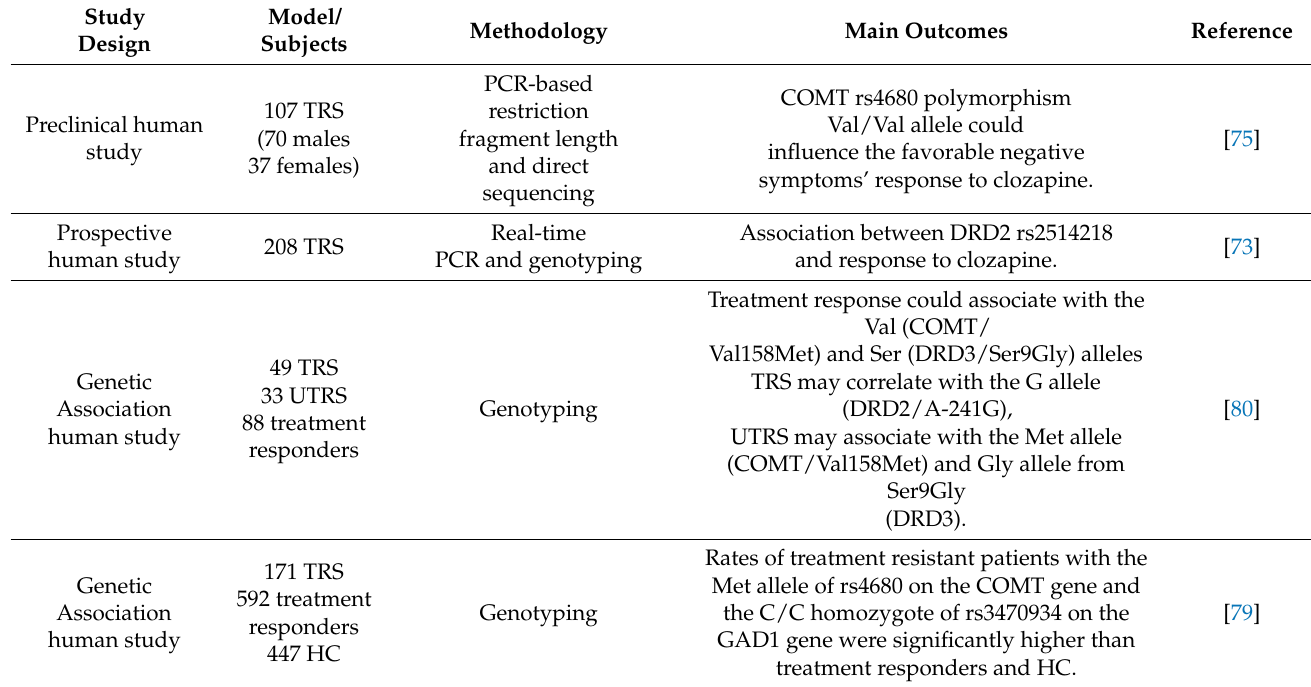
Table 3. Comparison of treatment resistant and treatment responder patients on dopamine-related genetic